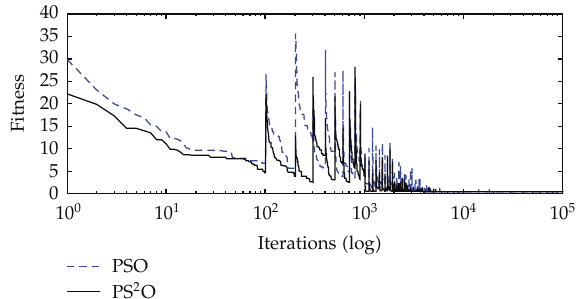
Figure 14: The base-level search process based on PS 2 O and